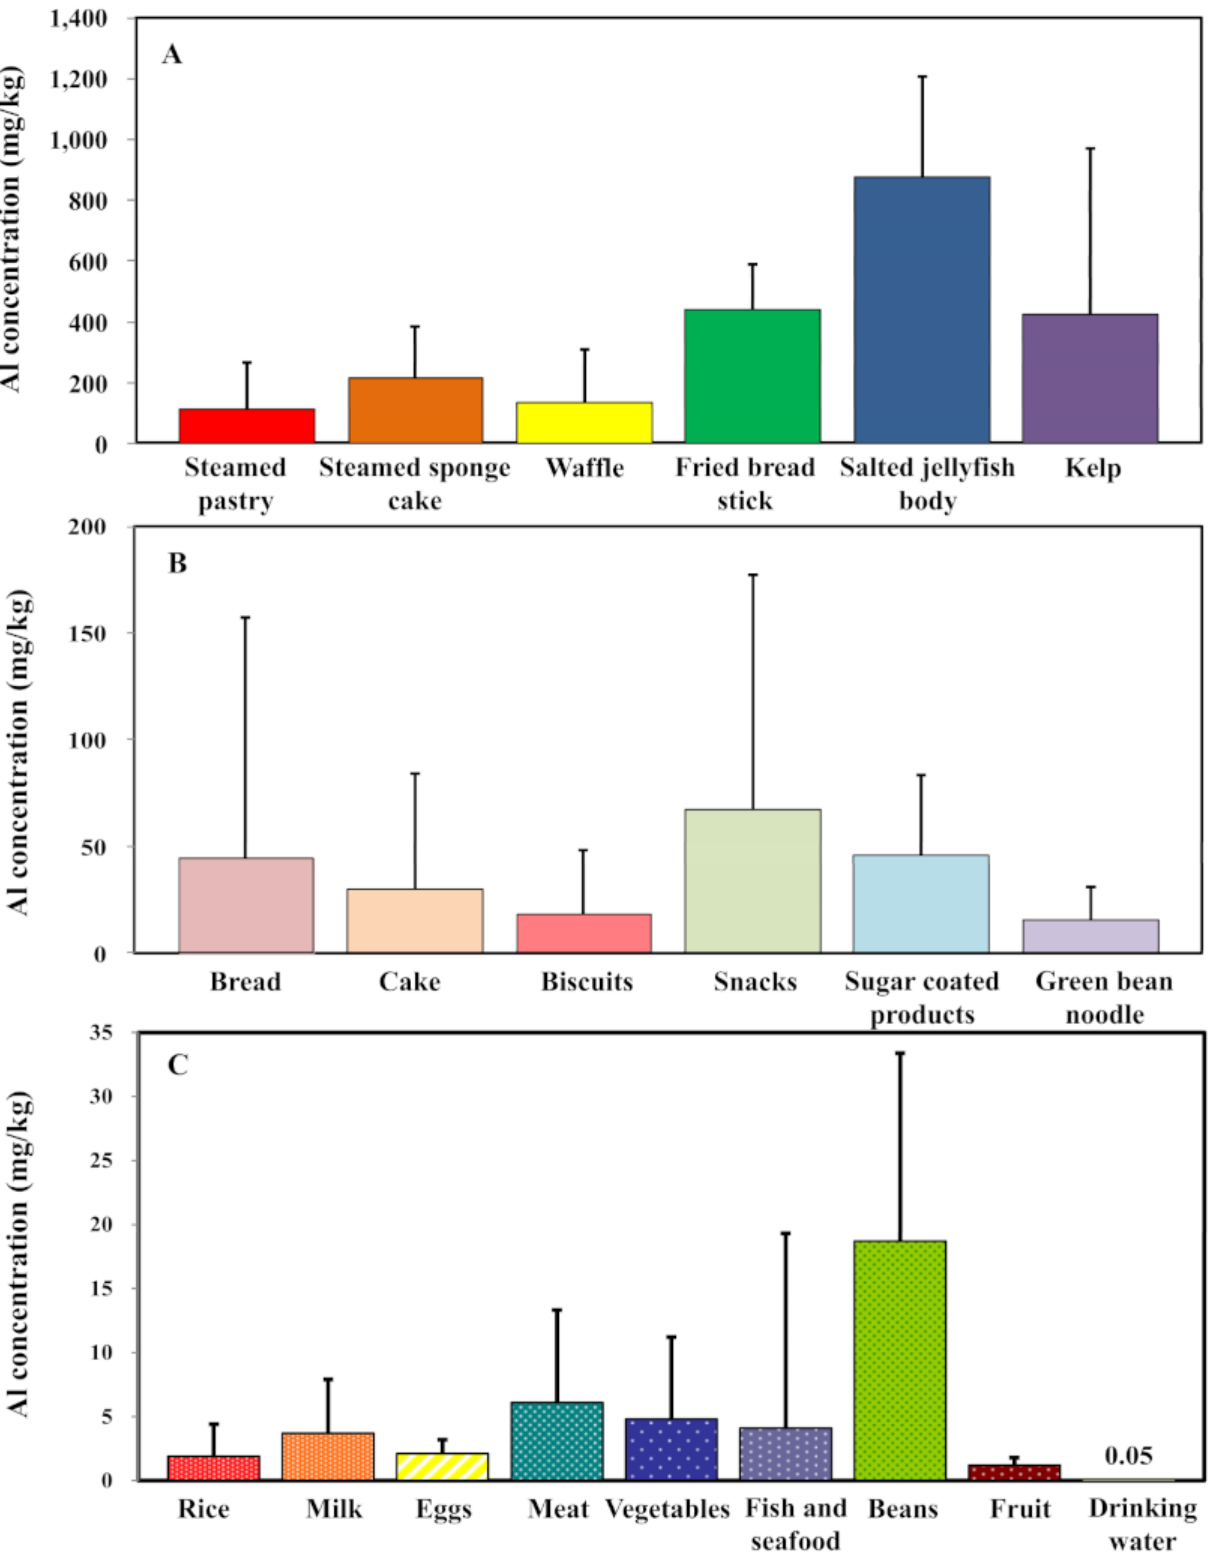
Figure 1. ( A , B ) Mean aluminum concentrations for 12 aluminum-rich food items (mg/kg) in Taiwanese regions (adopted from Zhou [25] and Yeh et al. [26]. The bars indicate the standard deviation (SD) for each food category. ( C ) Mean aluminum concentration of nine additional food consumption items (mg/kg) (adopted from Jiang et al. [21] and Yang et al.